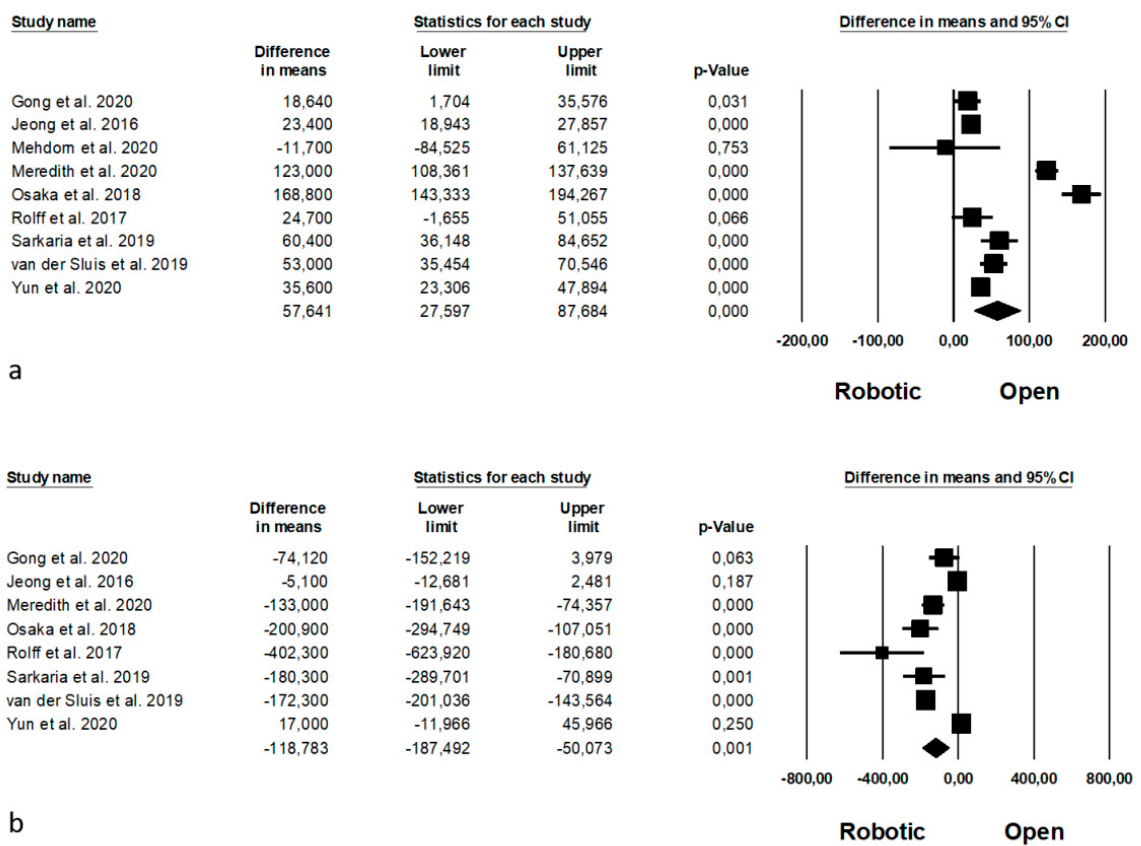
Figure 7. Robotic versus open surgery: intraoperative outcomes. ( a ) operative time; ( b ) estimated blood loss.